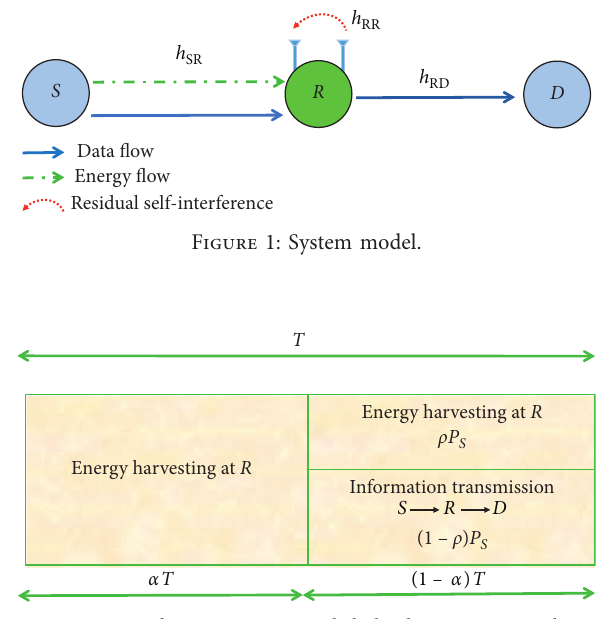
Figure 2: IT and EH processes with hybrid time-power-splitting relaying